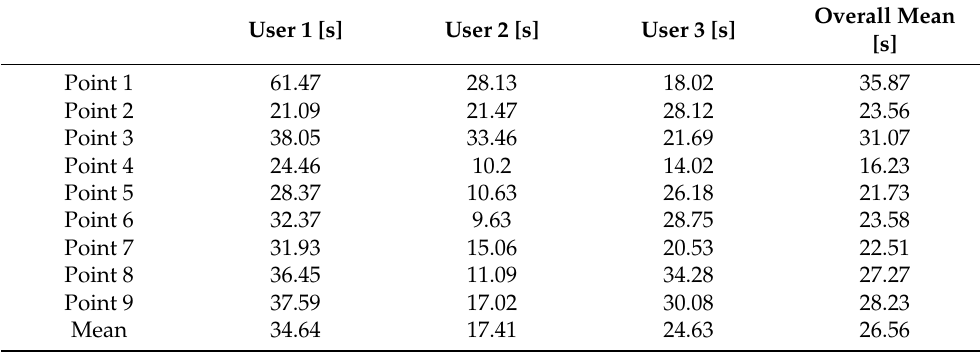
Figure 8. The results of the comparison of the ground truth values, the individual, and the mean positions of the drill tip by using the AR arrow. The positions were measured in { R } . Table 5. Results of the assessment of the execution